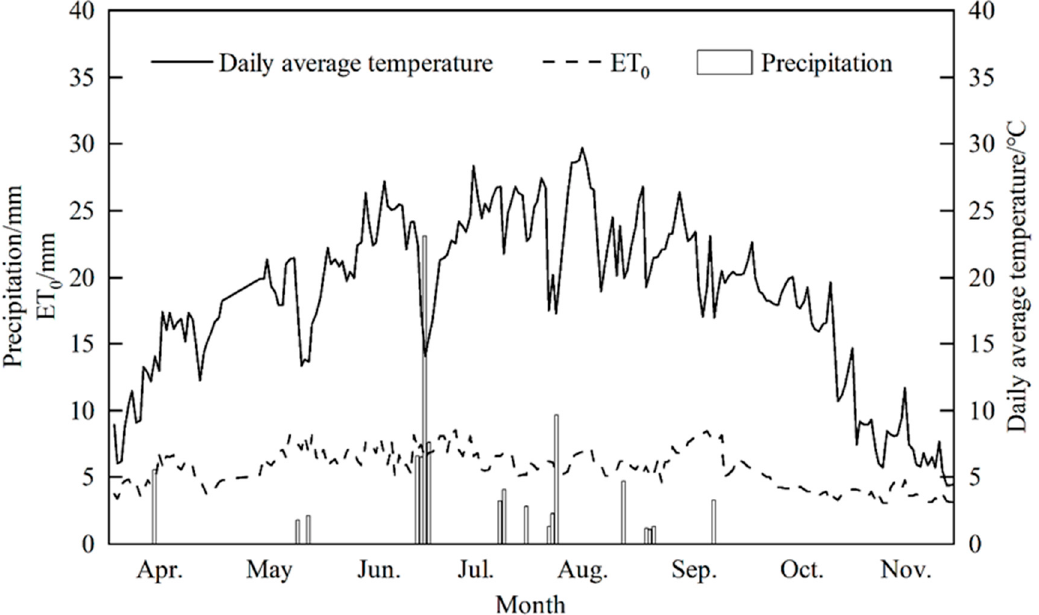
Figure 2. Daily average temperature (indicated by the curves), daily precipitation (indicated by the bars), and ET 0 (reference crop evapotranspiration, indicated by the dashed curve) during the jujube tree growing season at the experimental site in 2021. Table 1. Particle composition and physical properties of soil layers in the test area (soil dry bulk density and field water holding capacity).